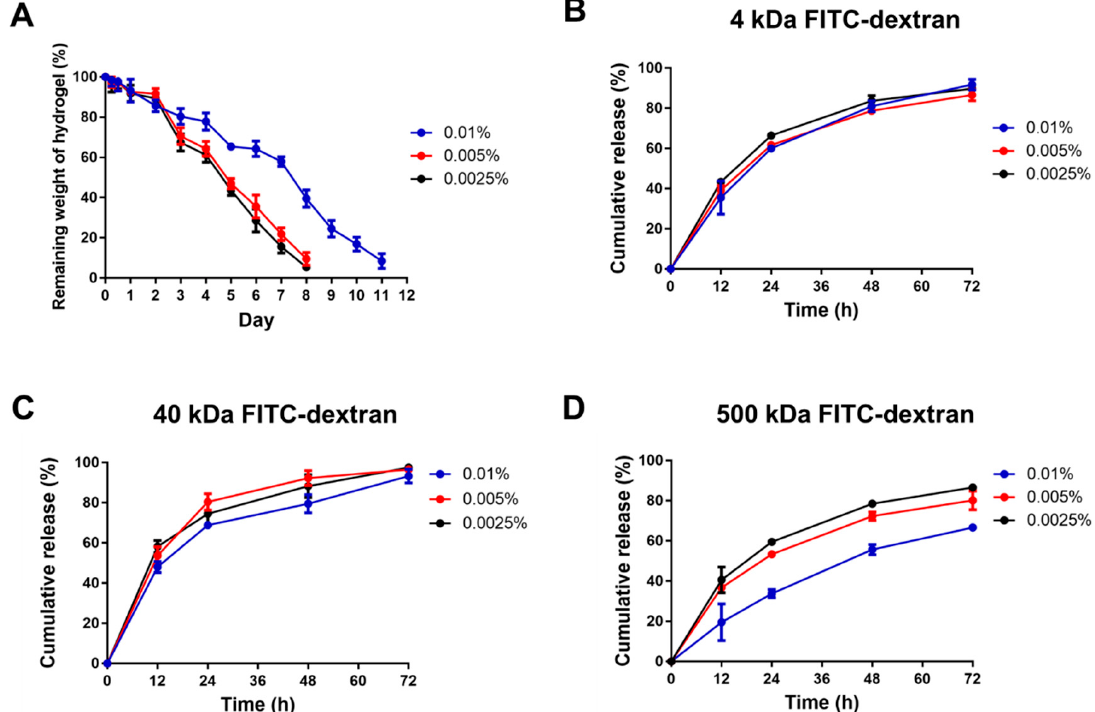
Figure 5. The degradation of CS-GE hydrogels and the release pattern of encapsulated FITC-dextrans. ( A ) In vitro degradation test of CS-GE hydrogel crosslinked with different concentrations of glyoxal. The release percentage of ( B ) 4 kDa, ( C ) 40 kDa and ( D ) 500 kDa FITC-dextrans from CS-GE hydrogels crosslinked with different glyoxal concentrations.